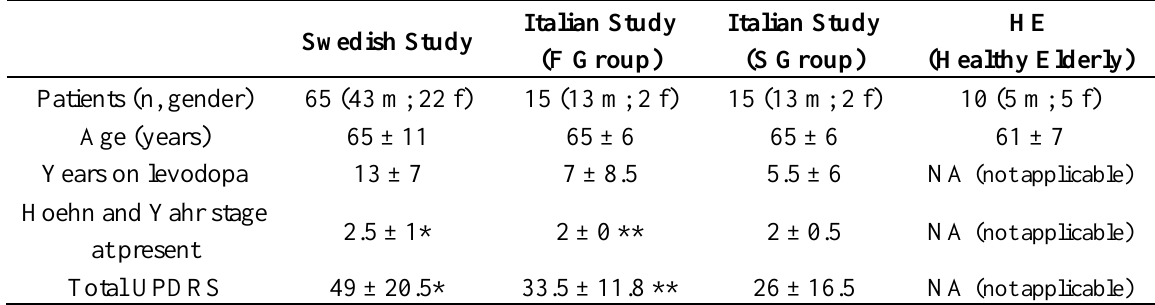
Table 1. Characteristics of PD patients and of healthy elderly participants, presented as median  interquartile